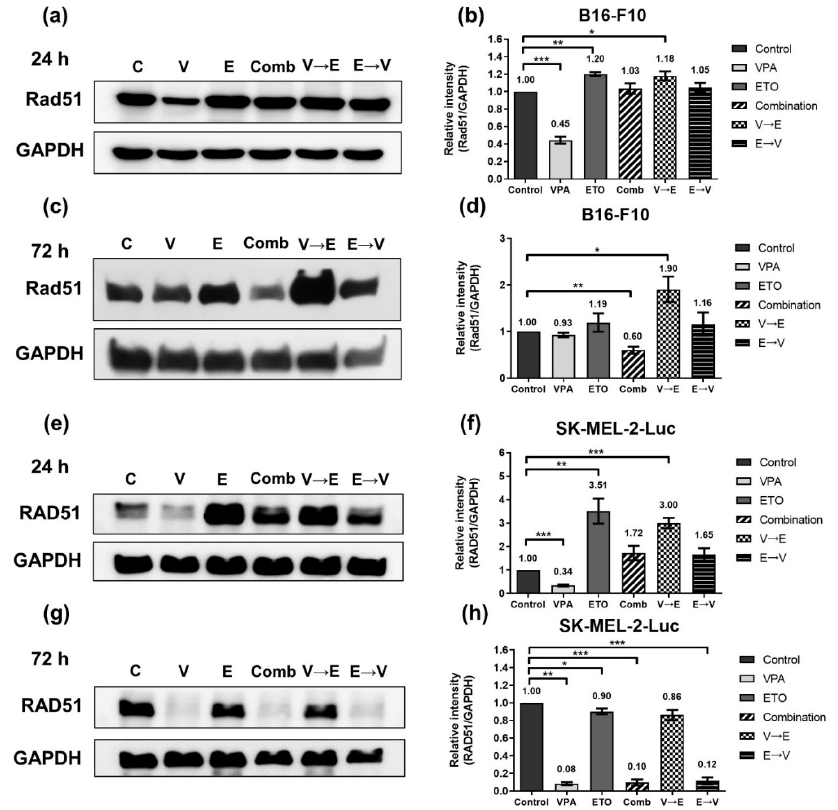
Figure 8. Expression of homologous recombination-related protein Rad51/RAD51, under single, simultaneous, and sequential combined treatments of VPA and ETO in melanoma cells. Western blot analysis illustrated the Rad51/RAD51 protein expression after ( a ) 24 h ( c ) 72 h single, simultaneous, and sequential combined treatments of VPA and ETO in B16-F10 cells. ( b , d ) was quantitative analysis of ( a , c ), respectively, which was obtained by using Image J software 1.52a (National Institutes of Health, Bethesda, MD, USA). The analysis was repeated in SK-MEL-2-Luc cells. Western blot data of ( e ) 24 h and ( g ) 72 h was shown, and the corresponding quantitative analysis was shown in ( f , h ), respectively. GAPDH was used as the control of sample loading. Relative intensities of Rad51/RAD51 to GAPDH expressions were normalized with the control. The data are shown as means ± SEM of independent experiments in triplicate. (* p < 0.05; ** p < 0.01; *** p < 0.001). The drug dosages were referred to IC 50 values as shown in Figure 2 and Table 1.